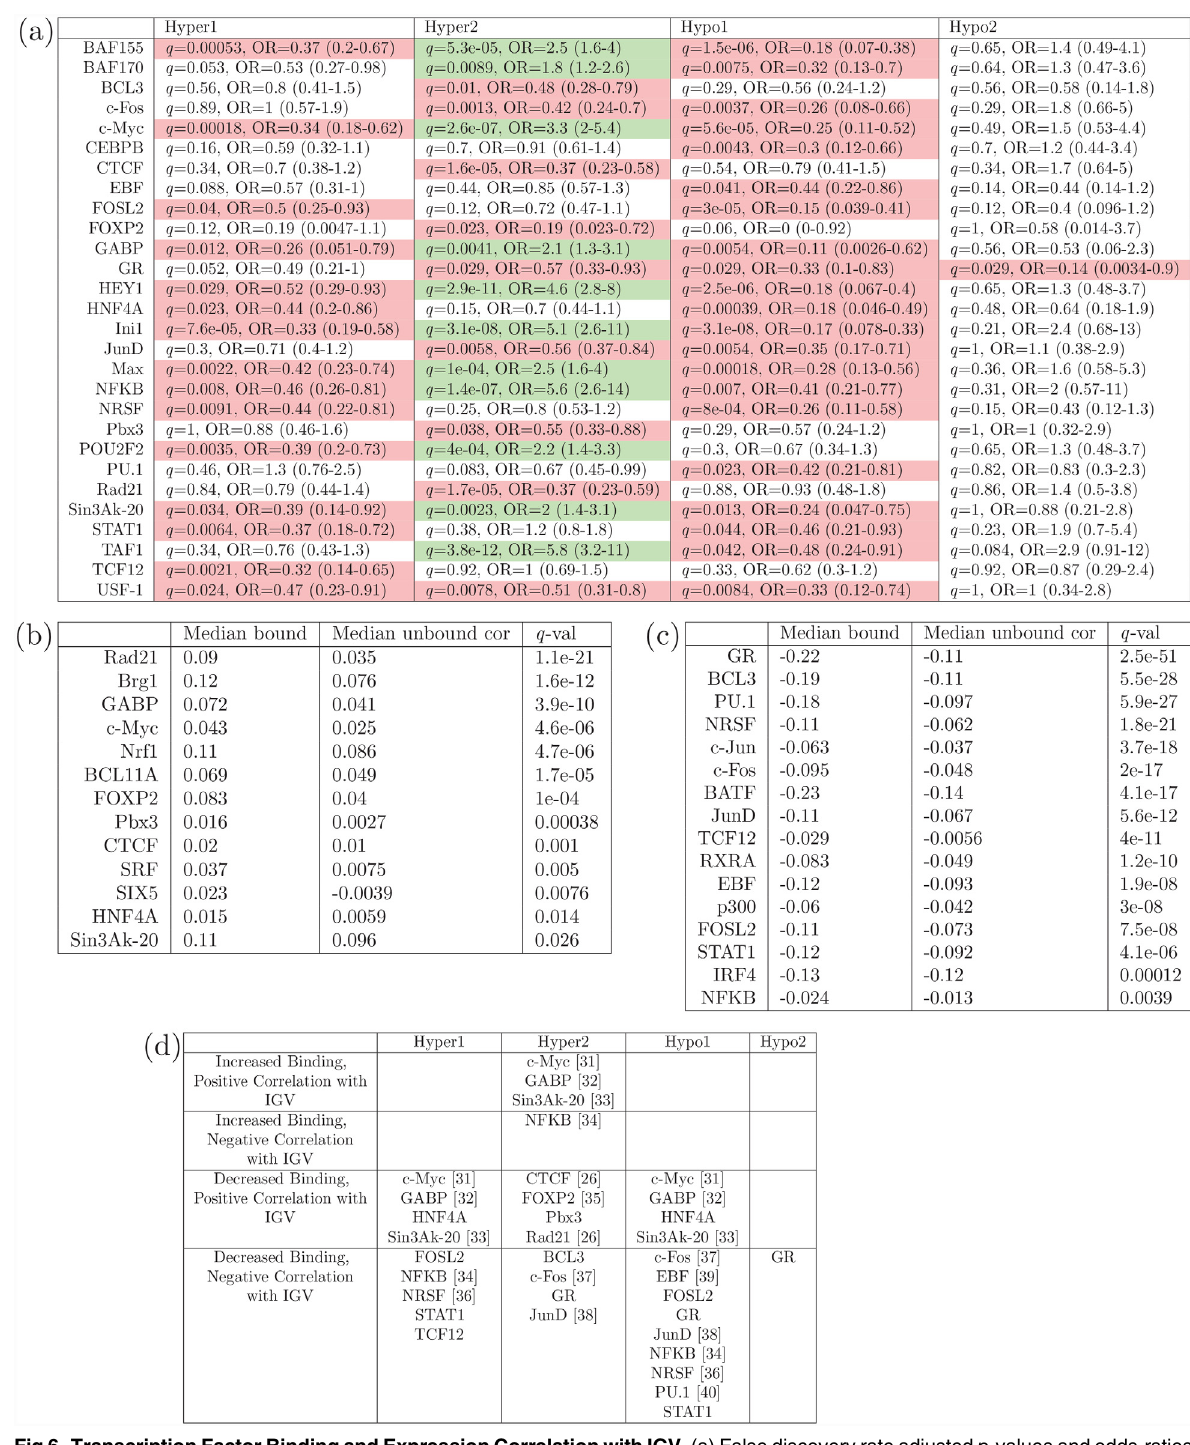
Fig 6. Transcription Factor Binding and Expression Correlation with IGV. (a) False discovery rate adjusted p -values and odds-ratios (OR) show enrichment of binding of specific transcription factors (TFs), to the gene body regions of the genes of each cluster. TFs for which binding is significantly over or under enriched (Fisher ’ s exact test, FDR q < 0.05) are coloured green and red, respectively. (b) TFs which show significantly more positive correlation with IGV of the genes they bind to, compared to the genes they do not bind to. (c) TFs which show significantly more negative correlation with IGV of the genes they bind to, compared to the genes they do not bind to. (d) TFs which are significant according to (a) and either (b) or (c); TFs with known relevance are indicated with a reference to the relevant study. The lack of enrichment of TF binding to the genes of cluster hypo2, is a reflection of the small number (19) of genes in this